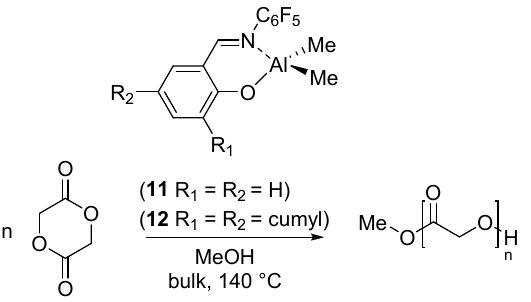
Scheme 6. Ring ‐ opening polymerization of glycolide (GA) by